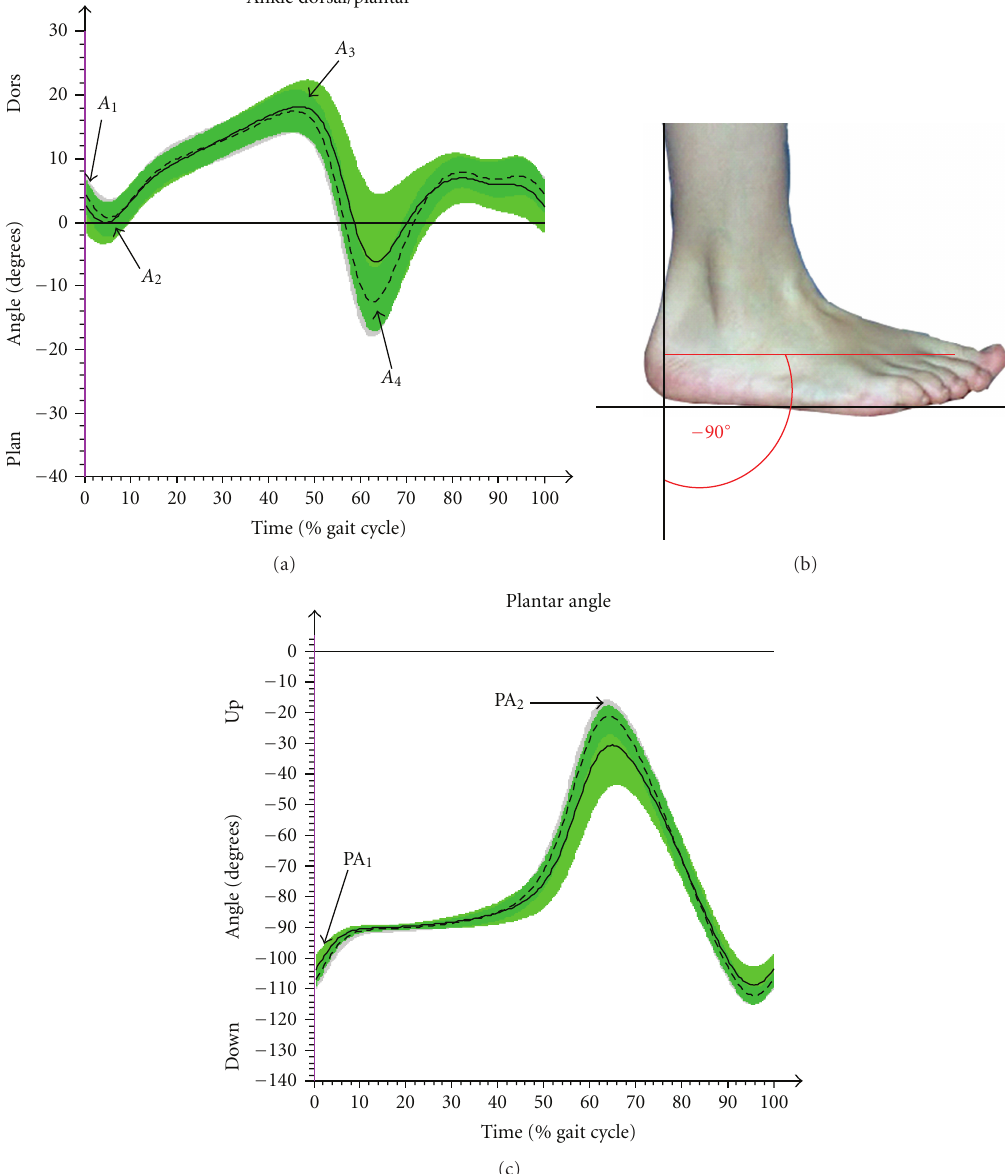
Figure 5: Results of CG (arithmetic mean & SD (---)) and JIA-P (arithmetic mean & SD (—)) in time normalized (%) gait cycle in ankle and plantar angle. (a) In ankle (dorsal/plantar flexion), A 1 (initial contact), A 2 (min. value of dorsal flexion in loading response), A 3 (max. dorsal flexion in stance phase), and A 4 (max. plantar flexion while push o ff or swing) were used for statistical analyses. (b) The plantar angle is the negative angle between the vertical to the ground and the foot longitudinal axis. (c) In plantar angle, PA 1 (initial contact), PA 2 (peak in swing phase), and the percentage of time while the foot is flat on the ground ( − 90 ◦ ( ± 2 ◦ )) were of interest.